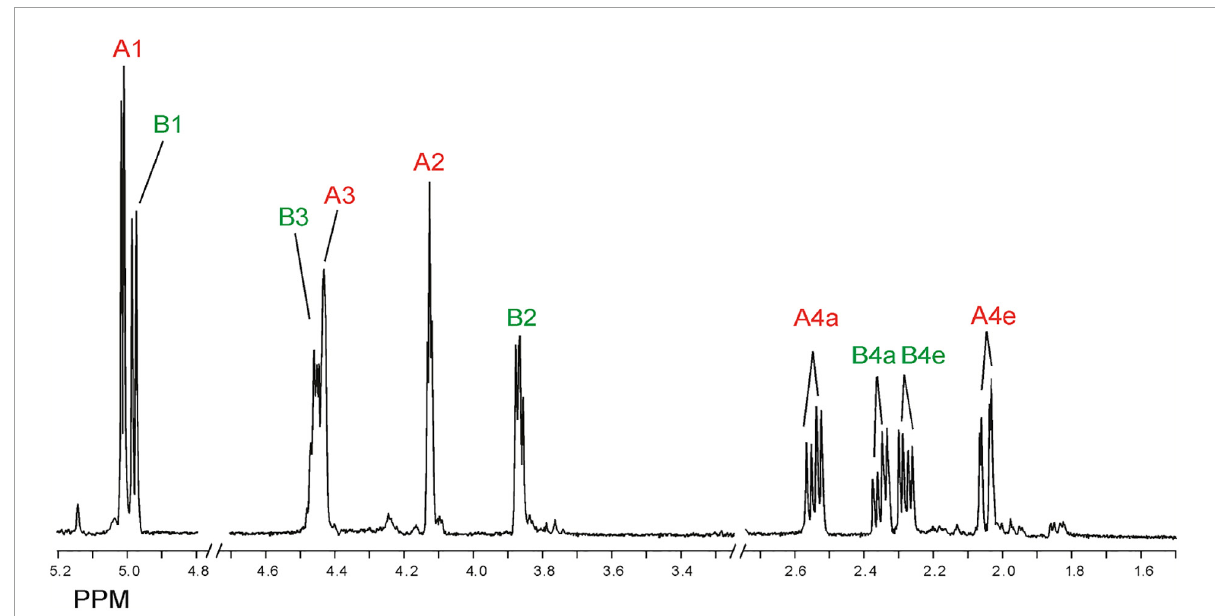
FIGURE8 1D 500-MHz 1 H NMR spectrum (300K, D 2 O) of Bio-Gel P-2 fraction II (cyclic stereoisomers A and B), obtained after 24-h of incubation of alginic acid with AlyRm4. Assigned according to Enquist-Newman et al. (2014). For 2D TOCSY and HSQC spectra, see Supplementary Figure 8 . A1 means H-1 of structure A (red), etc., B1 means H-1 of structure B (green), etc. (for structures, see Figure 9 ).